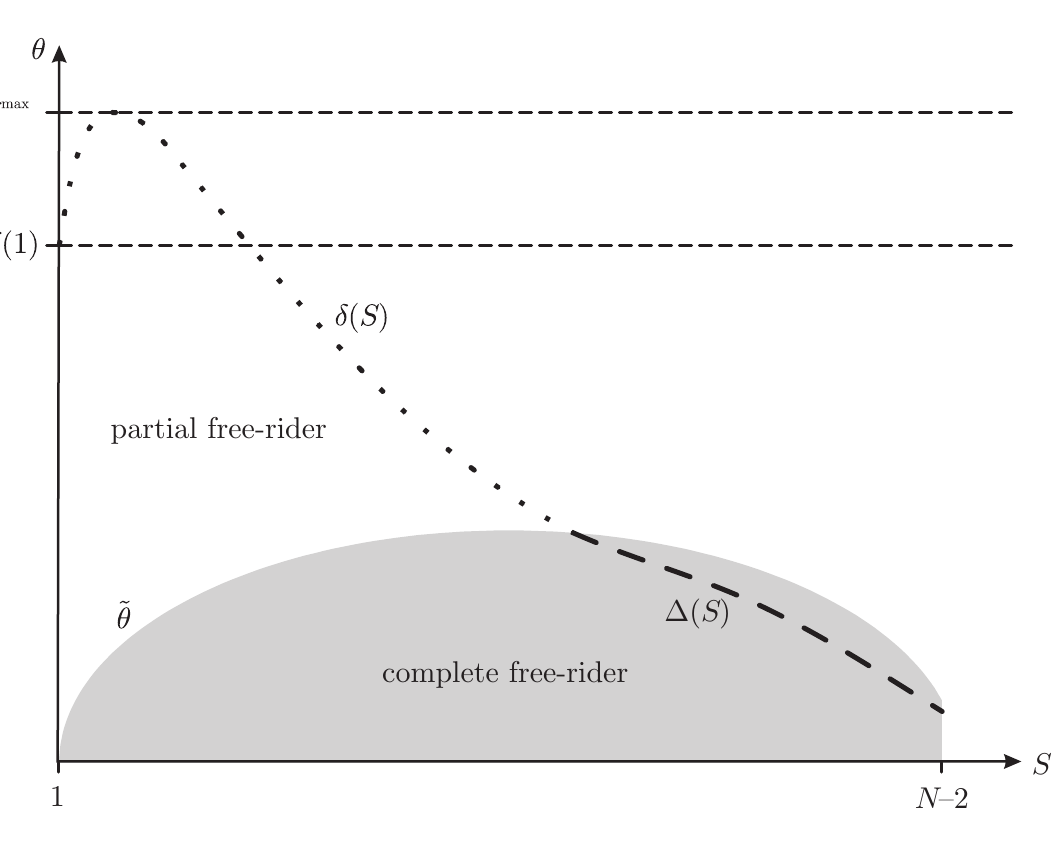
Figure 4. Stability analysis for N = 100